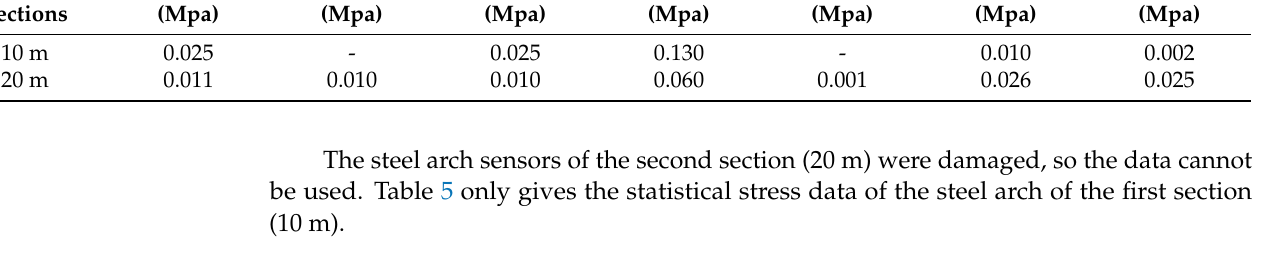
Table 5. Stress on the steel arch.